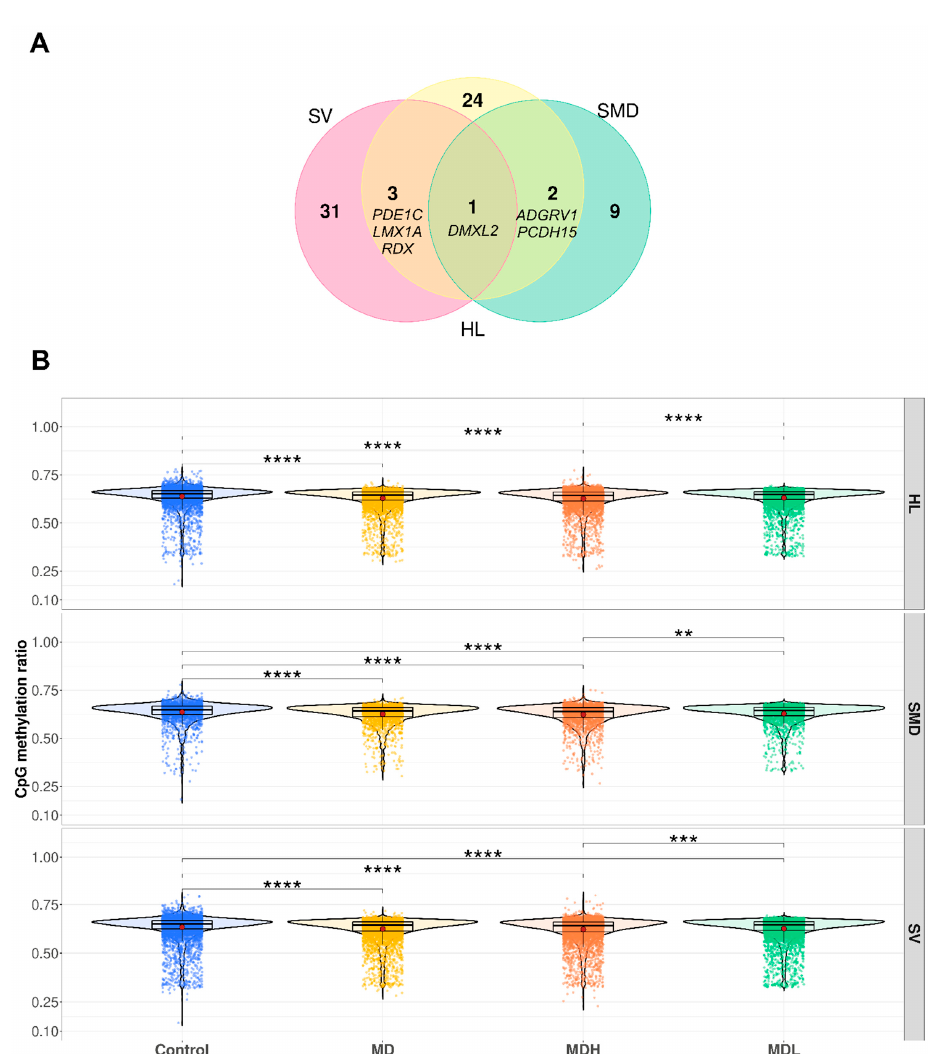
Figure 4. Differentially methylated CpGs present in inner ear gene sets. ( A ) Venn diagram representative of the number of genes in the Stria Vascularis (SV), HL (hearing loss) and Sporadic Meniere Disease (SMD) gene sets, which have DMC when comparing MD patients to controls. ( B ) boxplot representing the mean methylation of each CpG in the genes present in the Stria Vascularis (SV), HL (hearing loss) and Sporadic Meniere Disease (SMD) gene sets in controls (blue), all Meniere disease patients (yellow), Meniere disease patients with high cytokines (MDH) (orange) and Meniere disease patients with low cytokines (MDL) (green). Independent Student’s t -test was used to calculate the p -value in each comparison (Table S12). **— p -value < 0.01; ***— p -value < 0.001; ****— p -value <